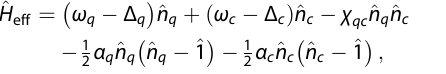
Fig. 2 Quantizing a simple circuit. a Illustration of a 3D cavity enclosing a transmon qubit chip. The cross symbol marks the location of a Josephson junction. Vertical blue arrows depict the (cid:6) (cid:7) ! ! electric fi eld E of the fundamental cavity mode, TE 101 . b m r Equivalent two-mode lumped-element representation of the dis- tributed circuit. Operators ^ a q and ^ a c denote the qubit and cavity mode operators,